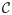
Cartoons of muscle and the model of local coupling.A. Size scales in muscle. Muscle contracts due to the formation of transient links between thick filaments (made primarily of the protein myosin) and thin filaments (made of the proteins actin, troponin and tropomyosin). Contraction is regulated by troponin and tropomyosin. After binding calcium, troponin moves tropomyosin from a position where myosin binding to actin is obstructed (blue, blocked position) toward a position where myosin binding is unhindered (yellow, open position). B. Assumptions of the continuous flexible chain model [15–17]. Troponin-tropomyosin (Tn-Tm) is a slender, infinite, linearly elastic beam constrained to a plane and in a potential well, W(z). Myosin binding to actin induces a displacement of the Tn-Tm beam into the open position (yellow), and locally deforms it. C. Simplifying assumptions of the model. When nearby myosin molecules bind to actin (molecules 2 and 4), they uniformly displace the intervening Tn-Tm beam into the open position. When distant myosin molecules bind to actin (molecules 4 and 7), they each induce independent deformations of the Tn-Tm beam. D. Energy change of the thin filament (ΔE) due to myosin binding, as a function of the distance to a bound myosin (L). When L is small, Tn-Tm is displaced uniformly, and ΔE increases linearly with L (blue region); when L is large, each myosin displaces Tn-Tm independently, and ΔE is independent of L (green region). If the transition between these regimes is abrupt, the curve is defined by two non-dimensional parameters, C and ε. Note: in the presence of calcium, the Tn-Tm beam moves into the closed state (not pictured), which changes ε, but not C.